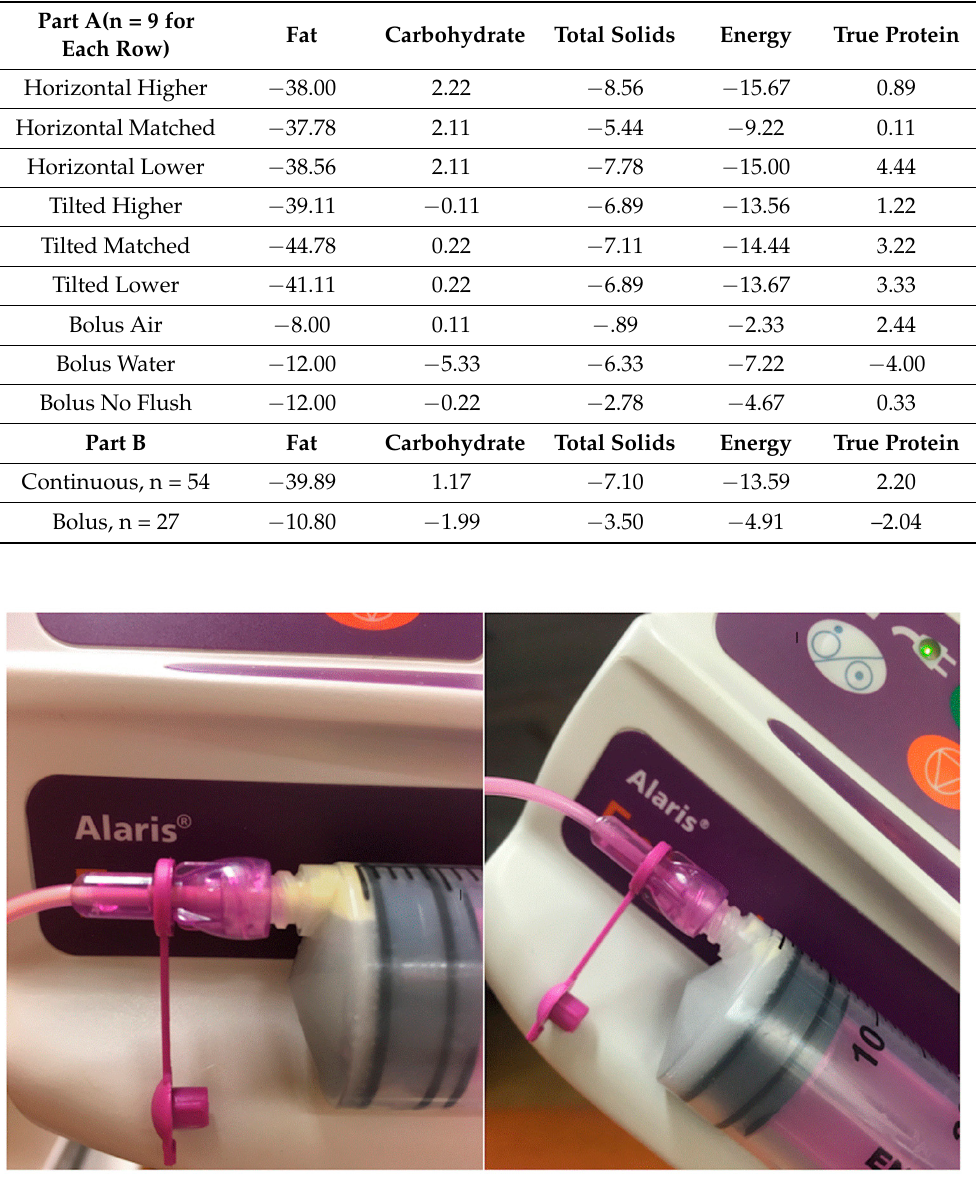
Figure 3. Visual fat loss after tilted and horizontal feeding simulations. Photo by author.